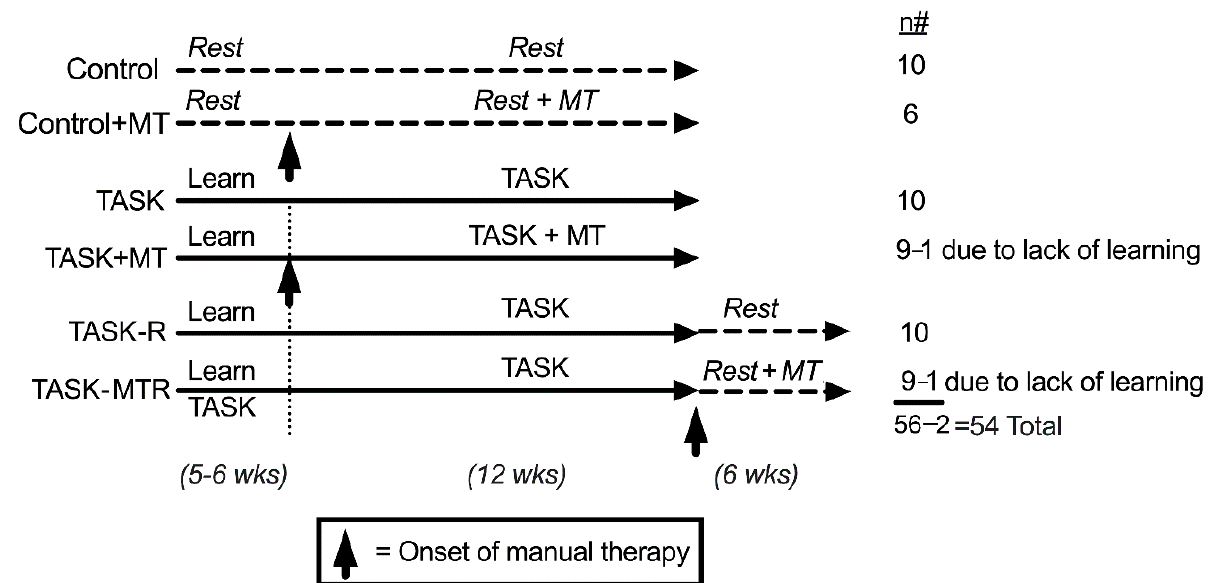
Figure 1. Experimental design. Abbreviations: control rats (Control); control rats that received manual therapy for 12 weeks (Control+MT); 12-week TASK rats (TASK); TASK rats that simultaneously received manual therapy for 12 weeks (TASK+MT); TASK rats that rested for 6 weeks after task cessation (TASK-R), TASK rats that rested for 6 weeks after task cessation while receiving manual therapy treatment of their upper limbs three times per week (TASK-MTR). n# = number of rats per group; wks = weeks.